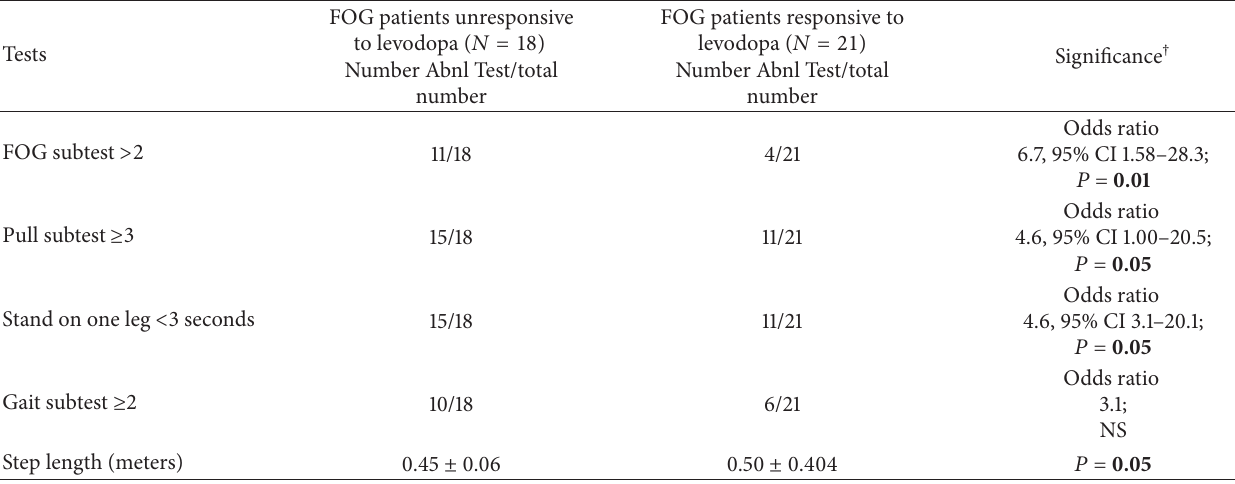
Table 2: Results of postural stability and locomotion tests on freezing of gait (FOG) patients unresponsive to levodopa compared to patients responsive to